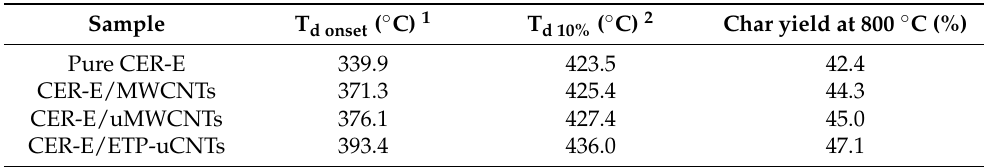
Table 3. Thermal stability in N 2 (TGA data) for pure CER-E, CER-E/MWCNTs, CER-E/uMWCNTs, CER-E/ETP-uCNT hybrid nanocomposites.